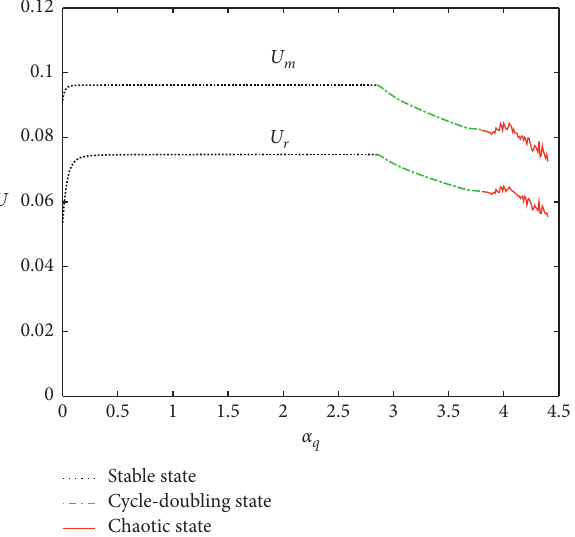
Figure 13: The average utility of manufacturer and recycler in different states of system